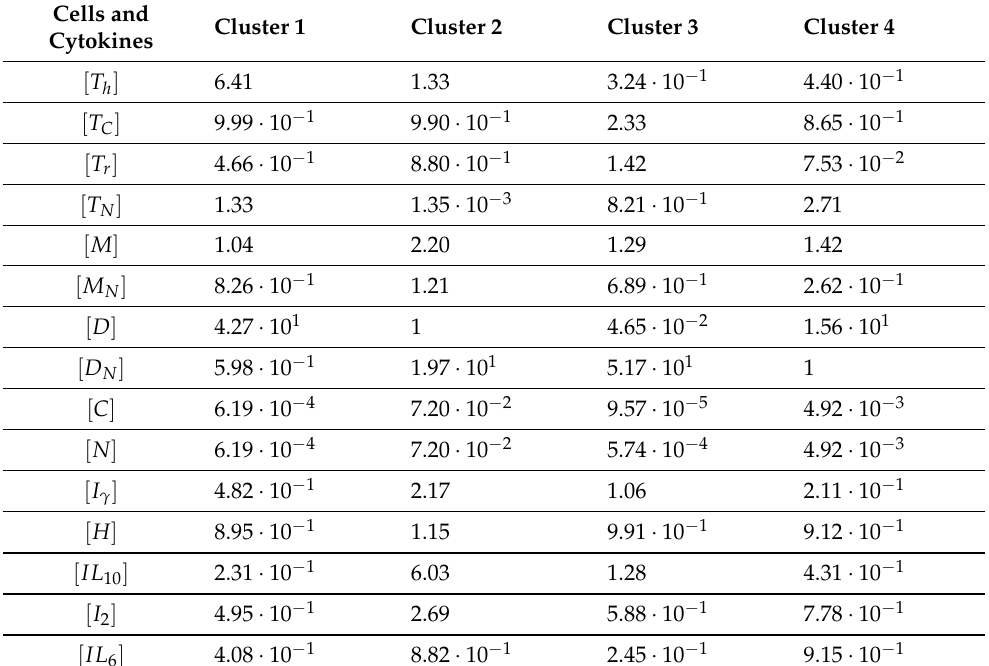
Table 2. Nondimensionalized initial conditions of each cluster. Cells